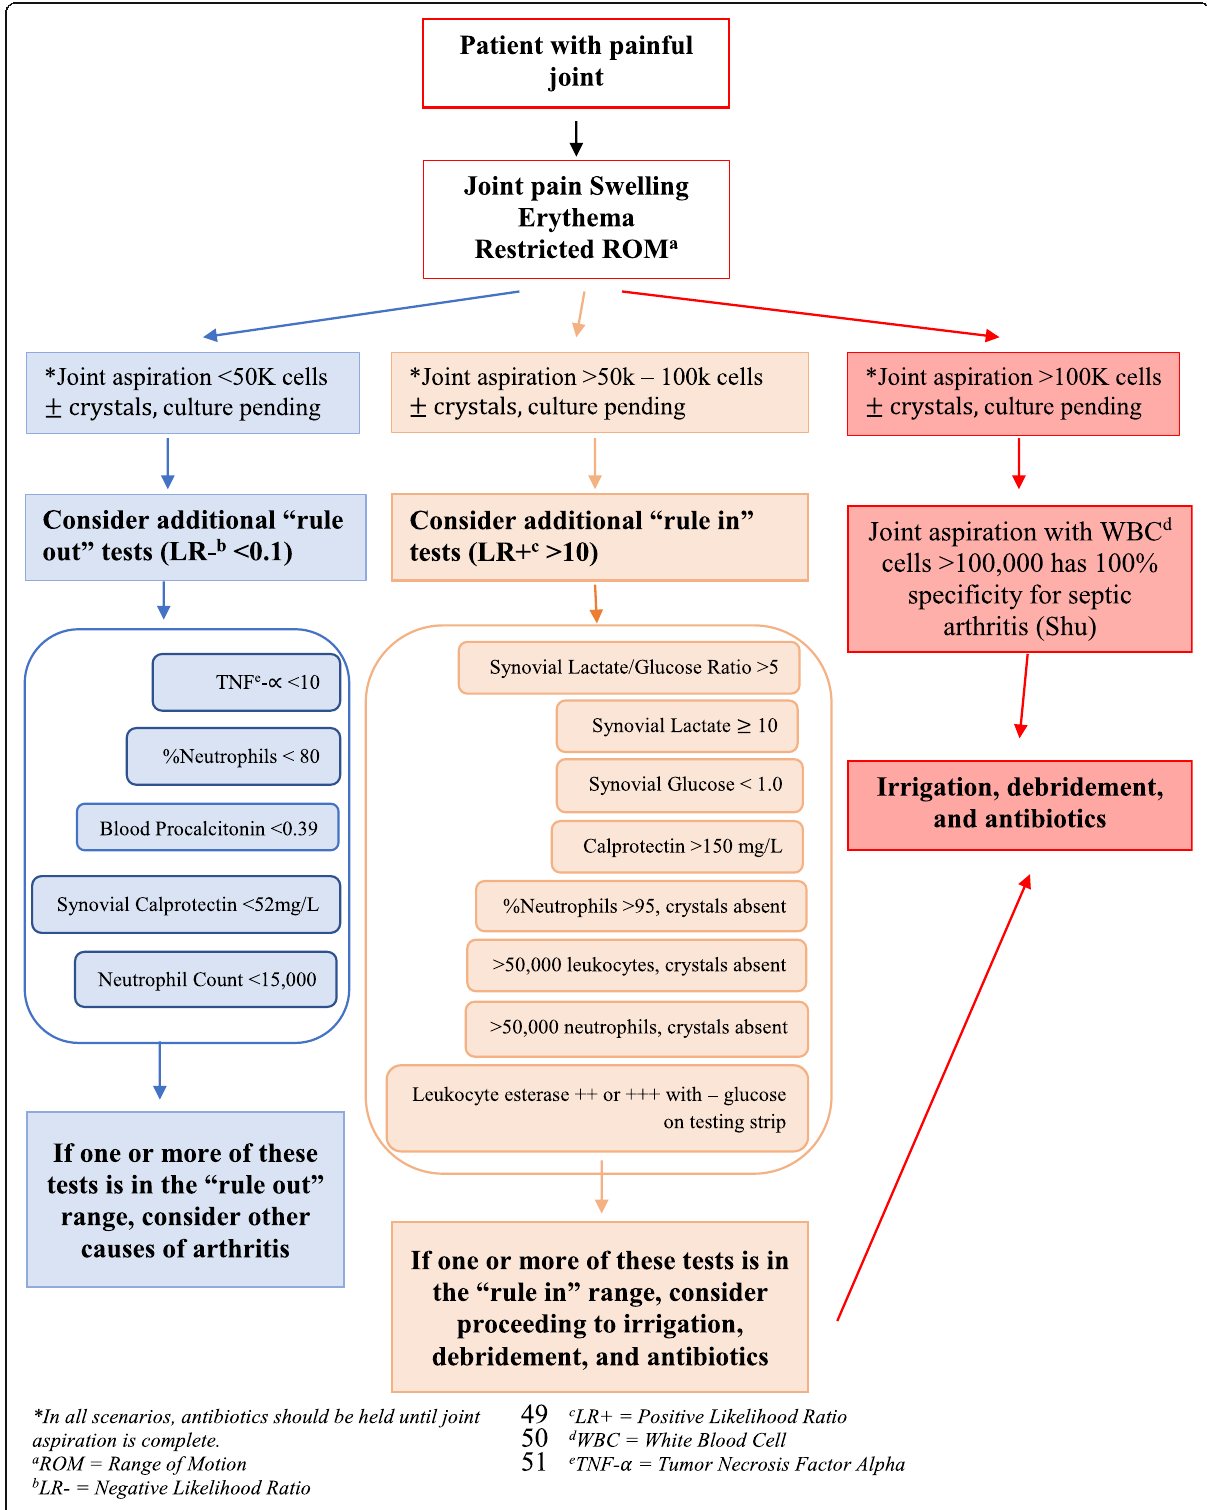
Fig. 2 Algorithm summarizing findings of this